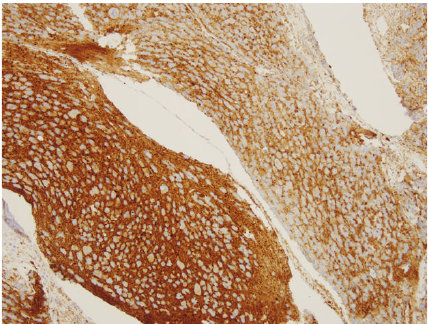
Figure 3: Immunohistochemistry of a paraffin section of the bone marrow biopsy using an antibody directed against synaptophysin demonstrates dense punctate cytoplasmic staining of the tumor cells, including staining of the neuropil. Magnification is